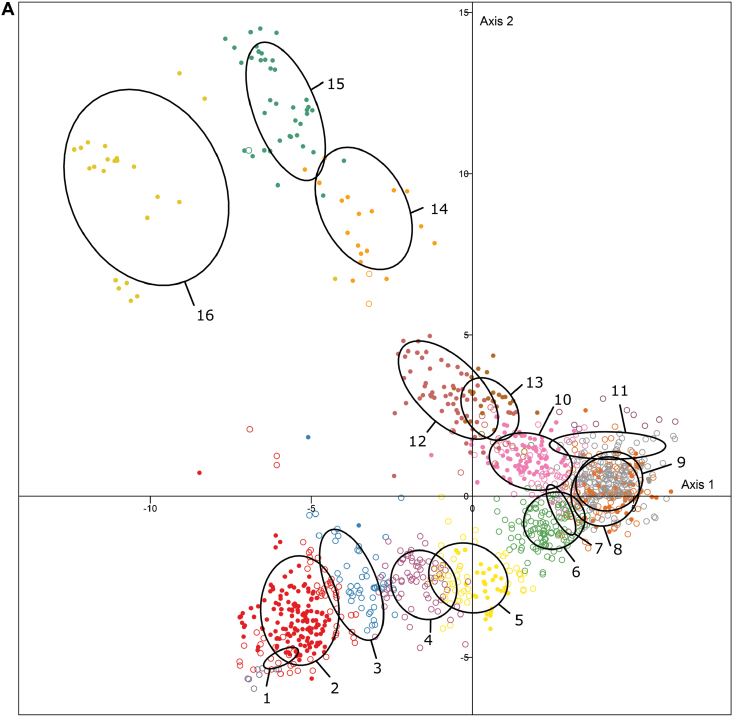
Representation of the first two axes of the discriminant analysis of principal components (DAPC) structuring results of the 1228 individuals. DAPC was made using the first three discriminant functions. The first two axes explain, respectively, 11.2% and 6.6% of the variance. (A) Display of the 16 genetic groups. Each group has a different color; filled circles represent correctly assigned individuals (membership probability ≥0.8), empty circles represent admixed individuals (membership probability <0.8). The ellipses represent the variance of the co-ordinates of the individuals for each group. (B) Geographical and temporal view of the DAPC analysis results. Black filled circles are cultivars created during each period; red filled circles are botanical roses; orange filled circles are Asian roses (botanical and cultivated) and empty circles are roses from other parts of the world or other periods. n, number of individuals. (C) Distribution of the French bred roses in the DAPC analysis according to the breeder’s region (black filled circles are cultivars created in each part of France; small circles are cultivars created in other parts of France) with the distribution of the breeding years of roses bred in this region given in the top right-hand corner. n, number of individuals. (D) Distribution of ploidy in the genetic groups obtained via DAPC. Individuals with measured ploidy levels and ploidy level found in the literature are presented